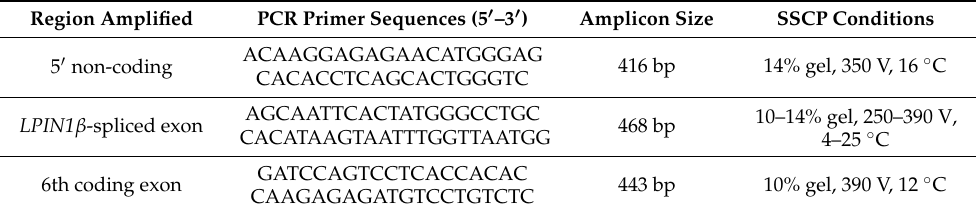
Table 1. PCR-SSCP conditions for the amplification and PCR-SSCP analysis of three regions of bovine